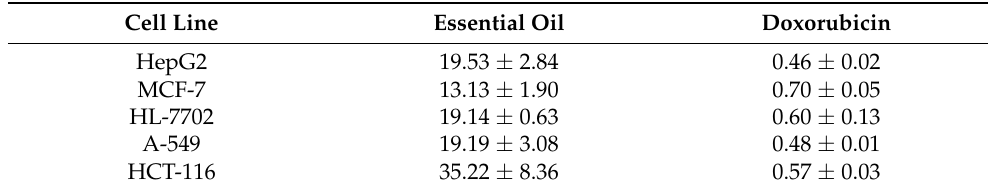
Table 5. IC 50 ( µ g/mL) ± SD values to the essential oil of M. nepalensis and positive control doxorubicin against cell